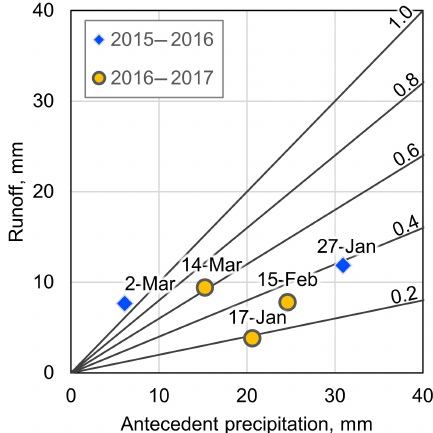
Figure 10. Relationship between snow accumulation and runoff generation during snowmelt events at the Triple G site. Solid lines correspond to different runoff ratios. Labels above data points indi- cate the date of complete snowpack depletion. Antecedent precipi- tation is the total precipitation that has occurred since the end of the last preceding snow-free